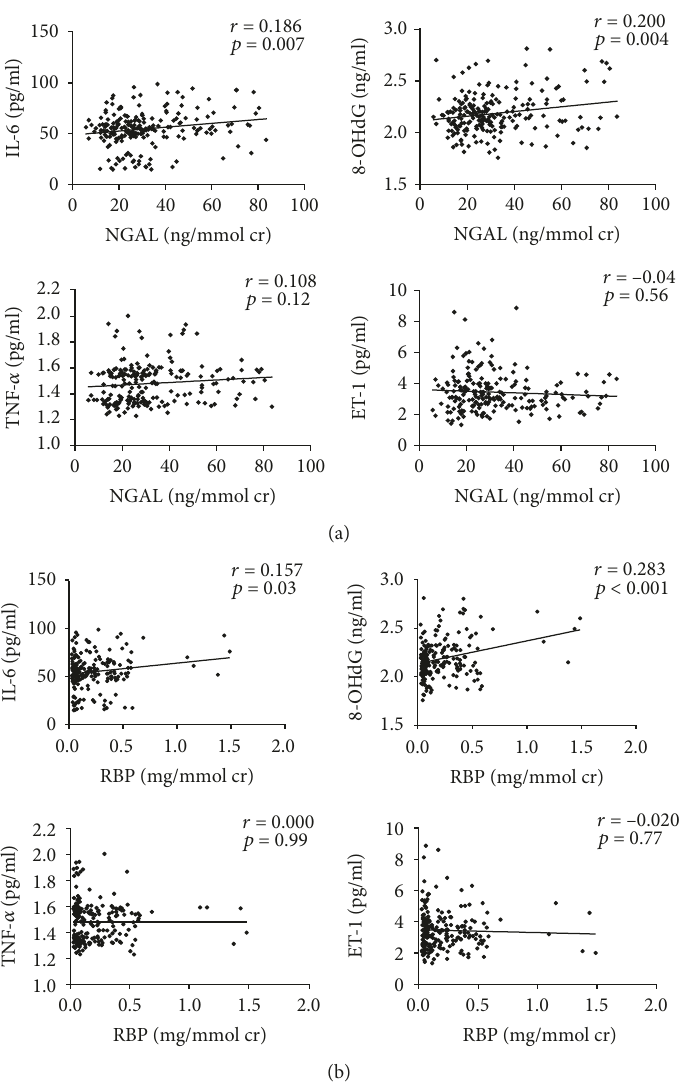
Figure 3: Correlations between plasma TNF- α , IL-6, ET-1, and 8-OHdG with urinary NGAL and RBP. (a) Single linear regression analysis of plasma TNF- α , IL-6, ET-1, and 8-OHdG and urinary NGAL. (b) Single linear regression analysis of plasma TNF- α , IL-6, ET-1, and 8-OHdG and urinary